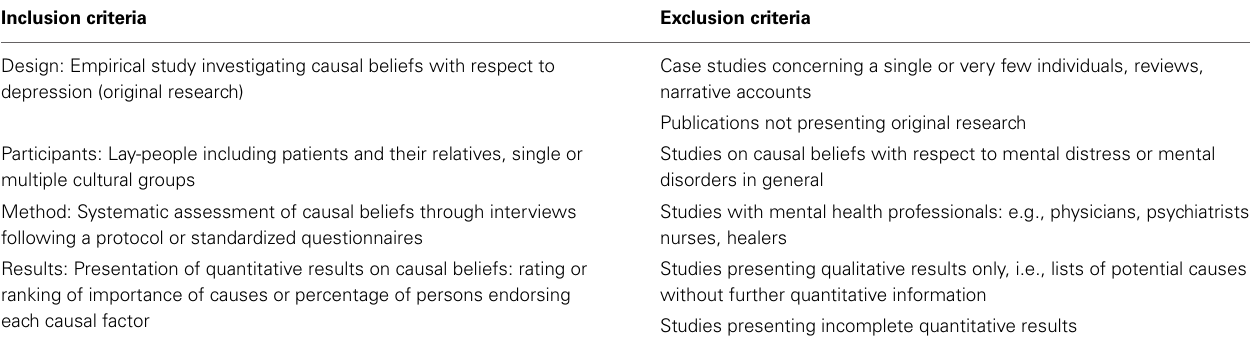
Table 2 | Inclusion and exclusion